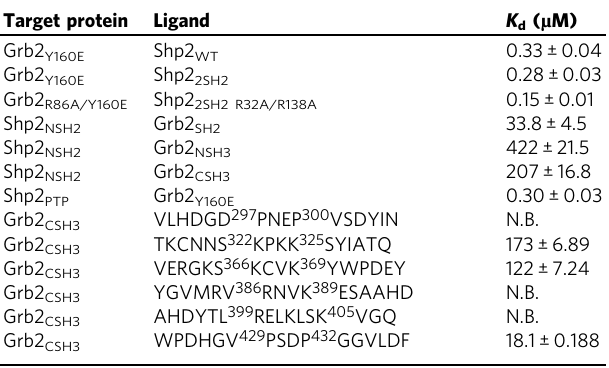
Table 1 Binding af fi nities ( K d, µ M) obtained from this study using